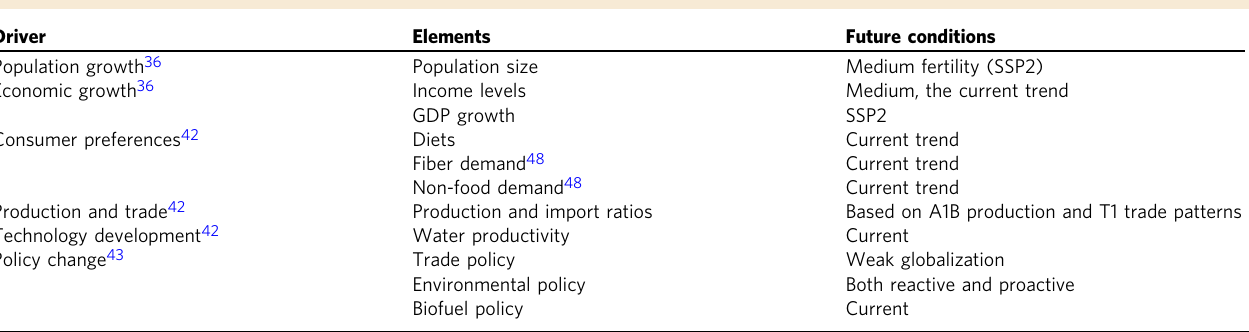
Table 1 Drivers and assumptions used in virtual water trade scenario model in this